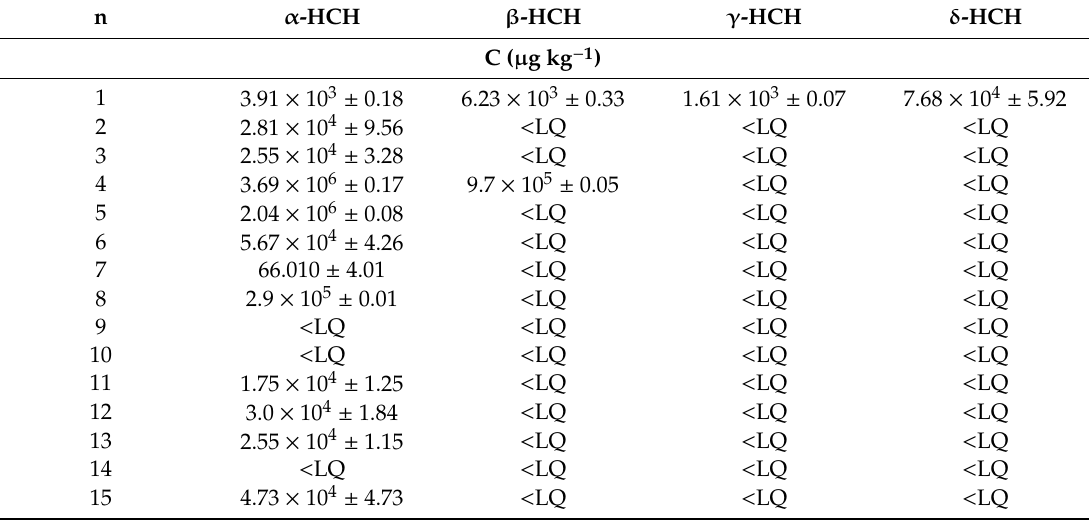
Table 8. Contaminant results of the samples (n) and their respective variation coe ffi cient (VC). n α